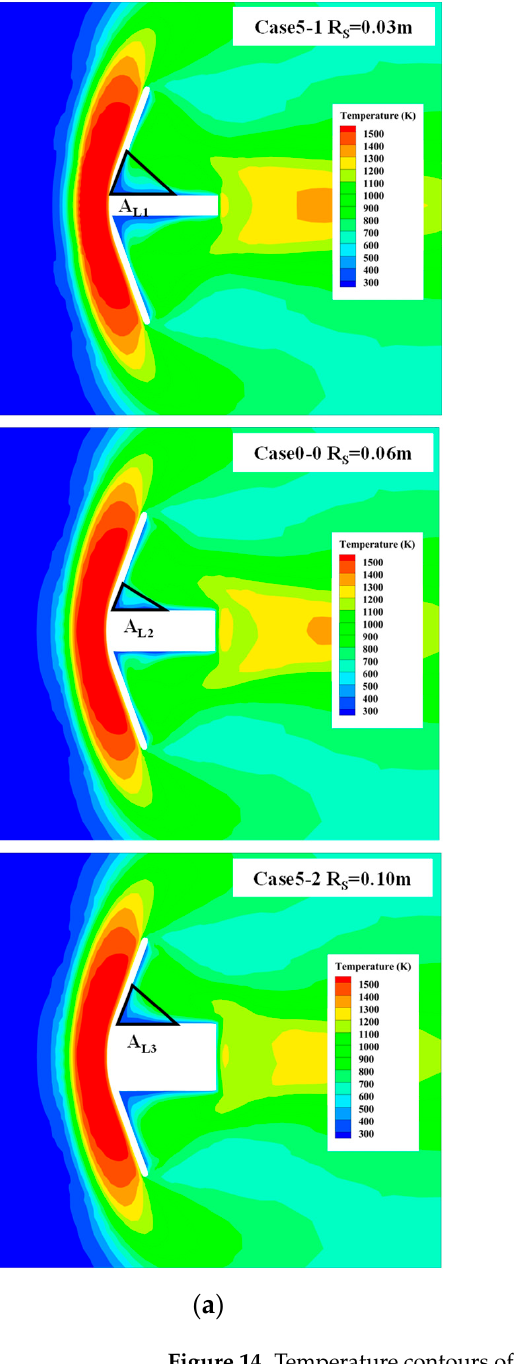
Figure 14. Temperature contours of case 0-0, case 5-1 to case 6-2: ( a ) R S is changed; ( b ) L Z is changed. It can be seen from Figure 15 that changing R S and L Z has li tt le e ff ect on the distribu- tion of the surface heat fl ux. Moreover, the value of Q O and Q R changes li tt le. It is worth mentioning that, when L Z increases to 0.50 m, the heat fl ux between the stagnation point and shoulder point is larger than that with the small L Z . This may be related to the length no longer causing the delay of the low temperature re fl ux area. R S and L Z have li tt le in fl u- ence on the surface heat fl ux.